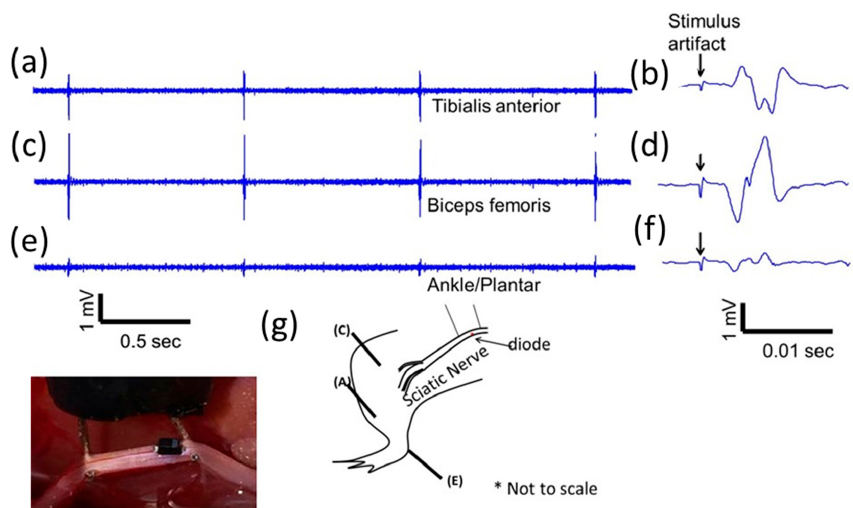
Figure 6. Representative electromyographic (EMG) responses from different muscle groups due to a single, remote, SC-79 packaged Skyworks diode stimulated with a high frequency (1 MHz) AC field by platinum hook electrodes. ( a , c , e ) are EMG responses at 1 Hz repetition rate. ( b , d , f ) are close-up of waveforms in ( a , c , e ) showing single EMG response with stimulus artifact indicated by an arrow. ( g ) Locations of EMG electrodes for the measurements in ( a , c , e ) in the hind limb. Inset shows a picture of a remote diode in free-floating placement on top of the nerve between two platinum based hook electrodes. Scale bar is 1 mm.